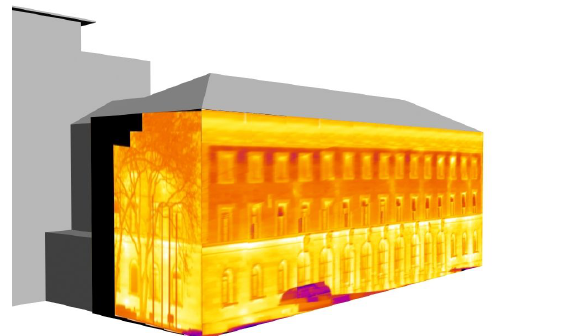
Figure 7. 3d building model with facade textures